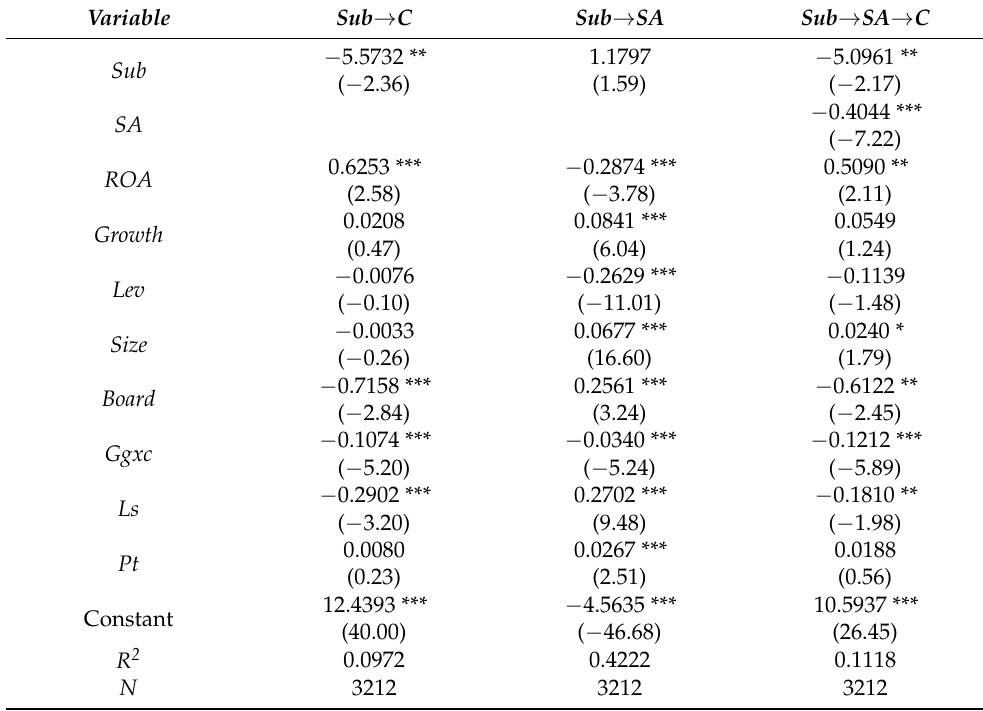
Table 7. Regression results of the role of financing